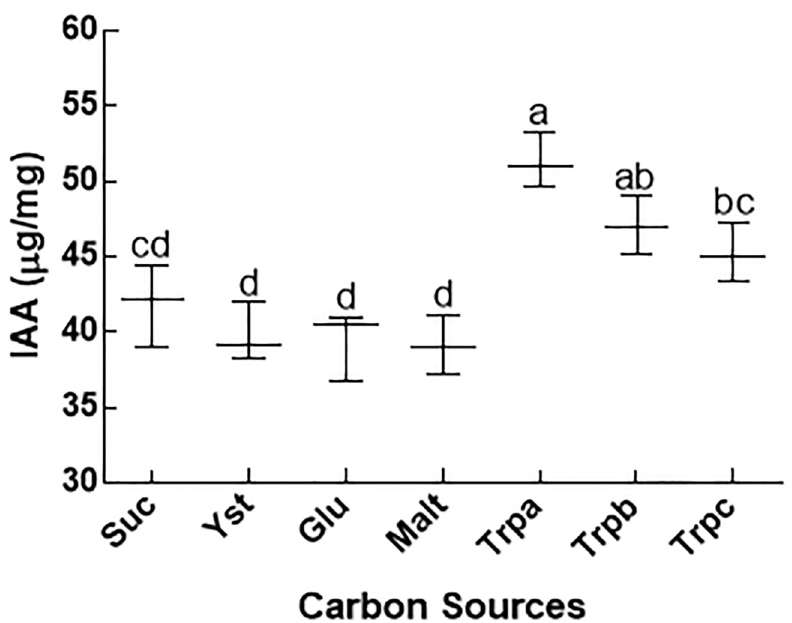
Fig 2. IAA estimation ( μ g/ml) in endophytic fungal strain CGF-1. CGF-1 strain was grown on different sources and the produced IAA was quantified by using HPLC. Suc = sucrose; Yst = yeast; Glu = glucose; Malt = maltose; Trpa = 1000 μ g tryptophan; Trpb = 500 μ g tryptophan; Trpc = 100 μ g tryptophan. The experiment was carried out in triplicate. The boxplots having different letters are significantly different from each other at P <